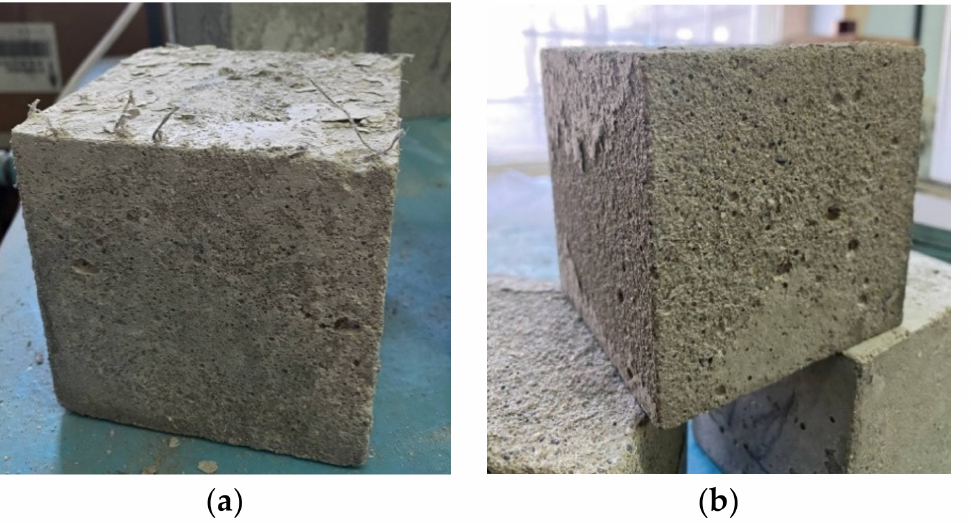
Figure 8. The studied specimens after freeze-thaw cycles.( a ) fiber concrete with polypropylene fiber; ( b ) fiber concrete with steel